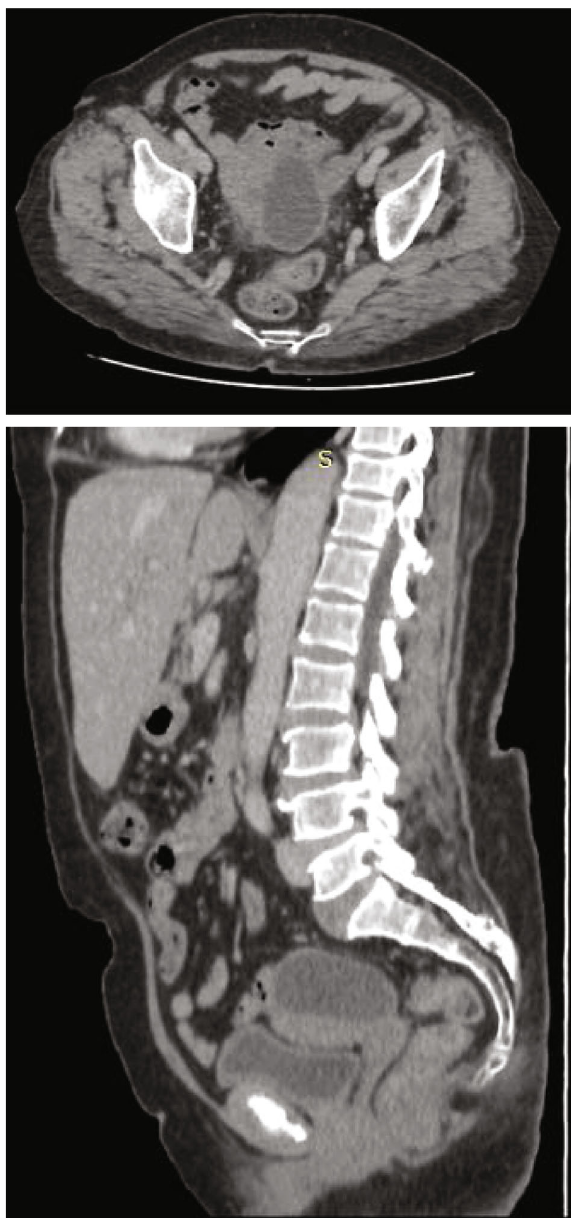
Figure 3: CT aspect of the